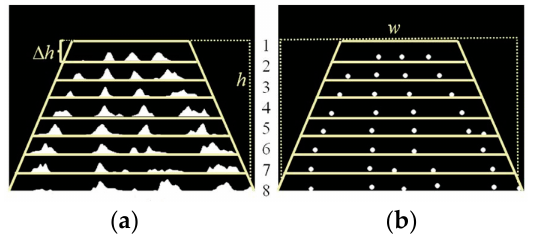
Figure 6. ( a ) Vertical projection; ( b ) Feature point collection.